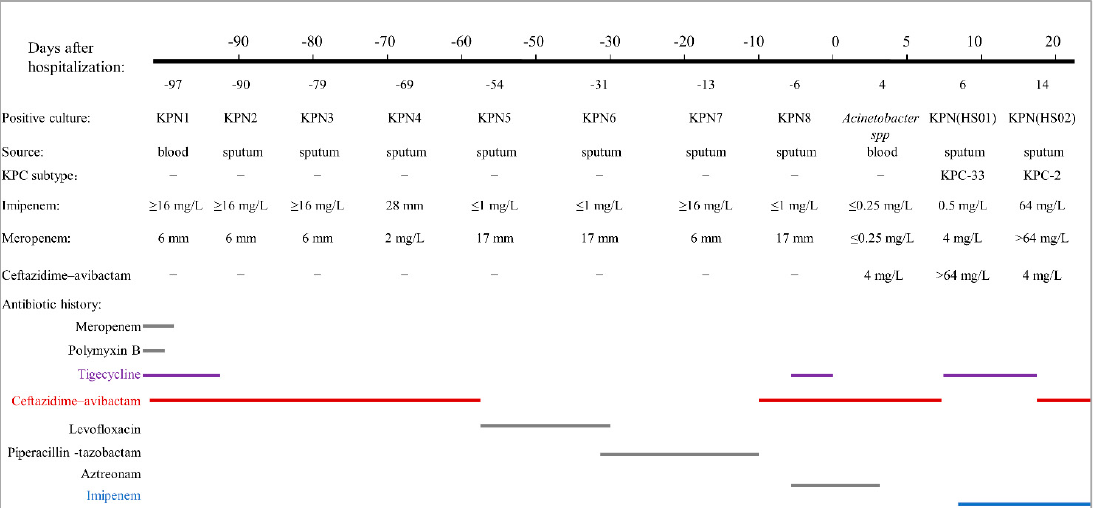
Figure 1. Antibiotic history and the results of microbiology cultures. (The doses of antibiotics are